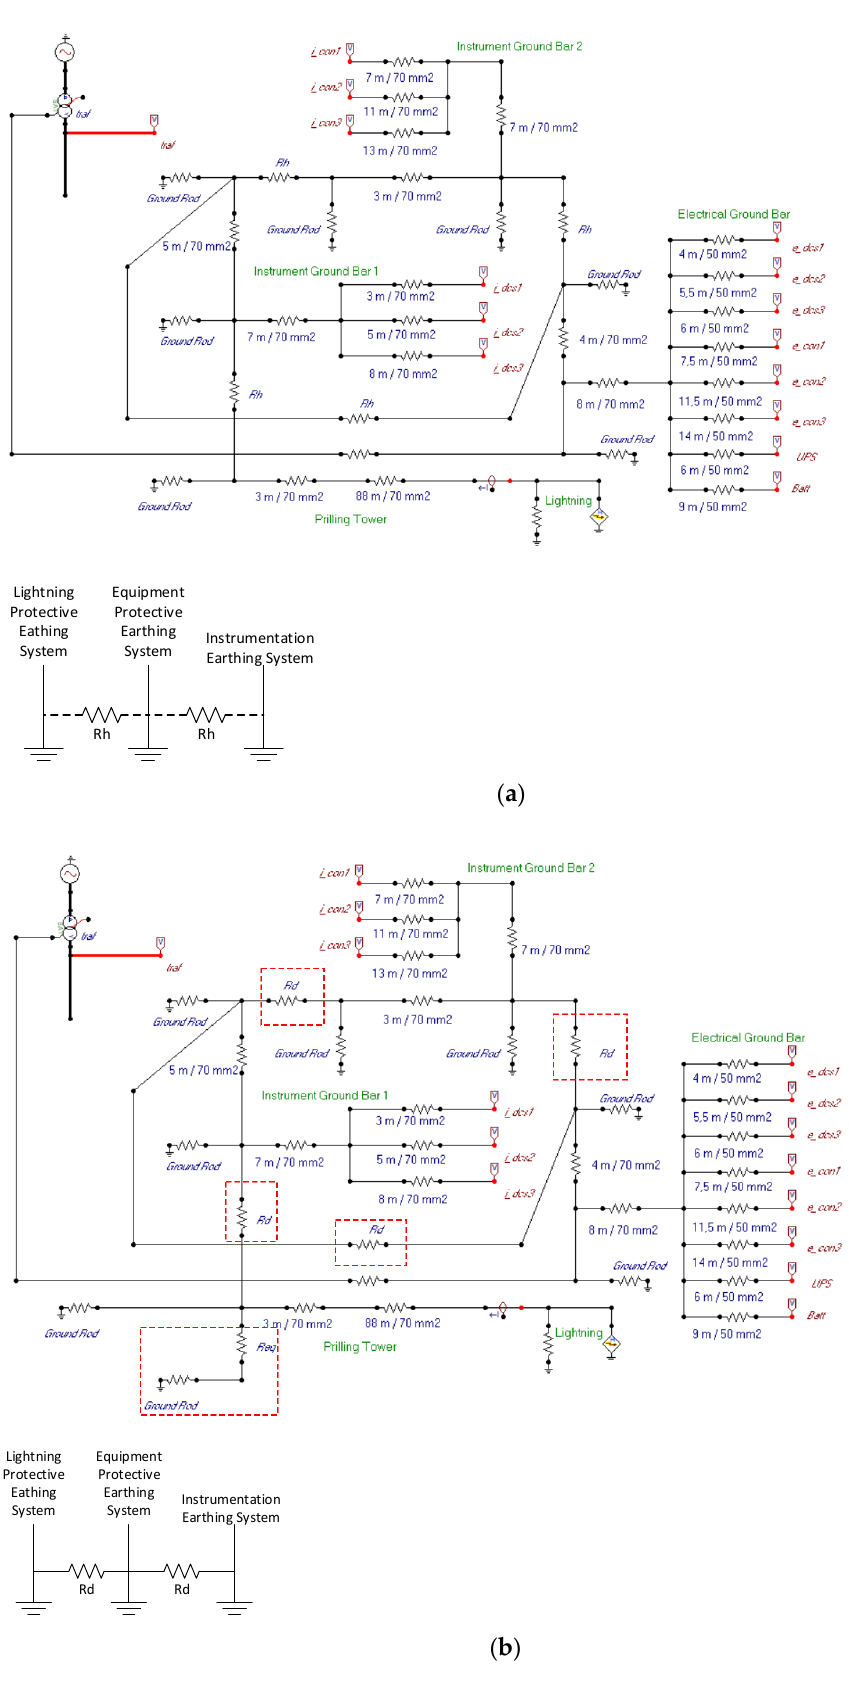
Figure 3. Models of grounding system: ( a ) existing system; ( b ) modified system.